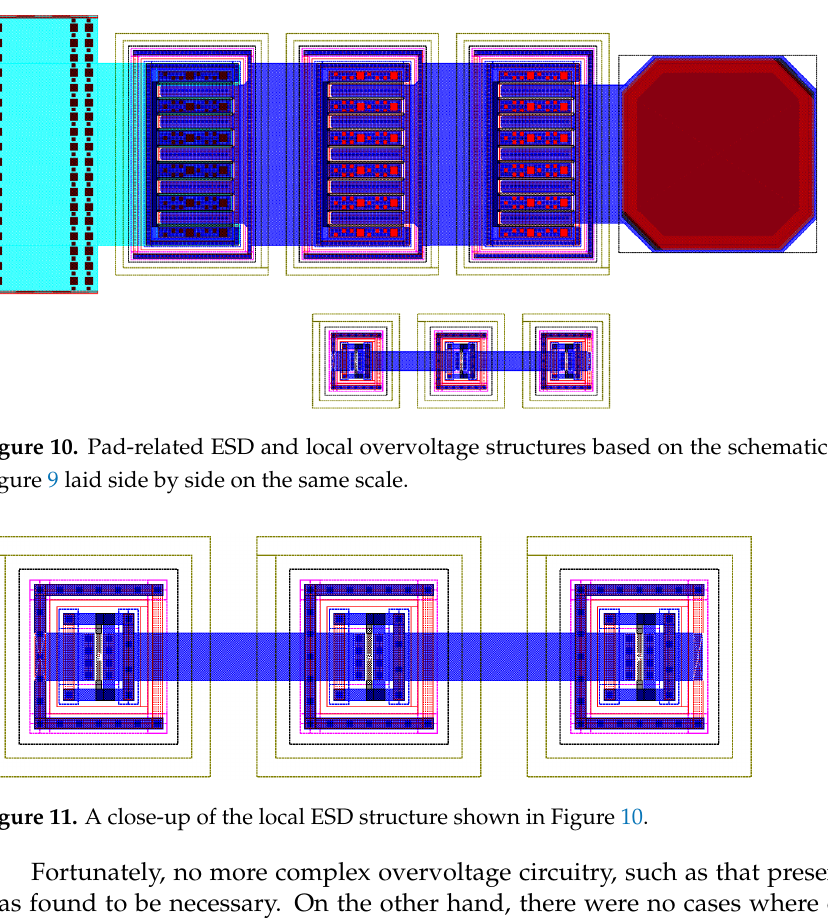
Figure 9. Schematic of an ESD/overvoltage device used on the input and output side of the buffer.